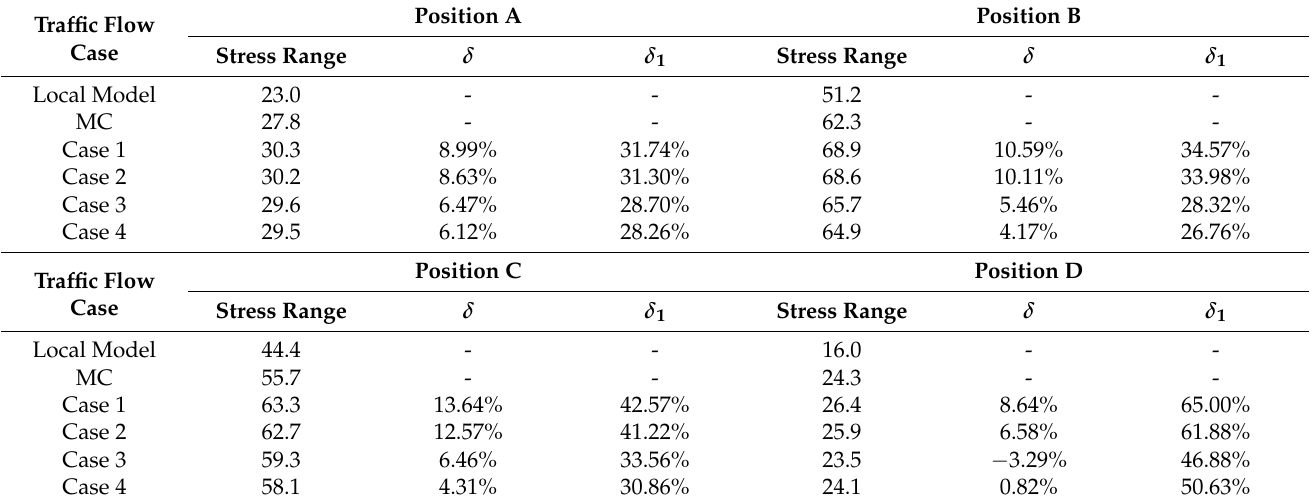
Table 3. Stress results of different traffic flows (unit: